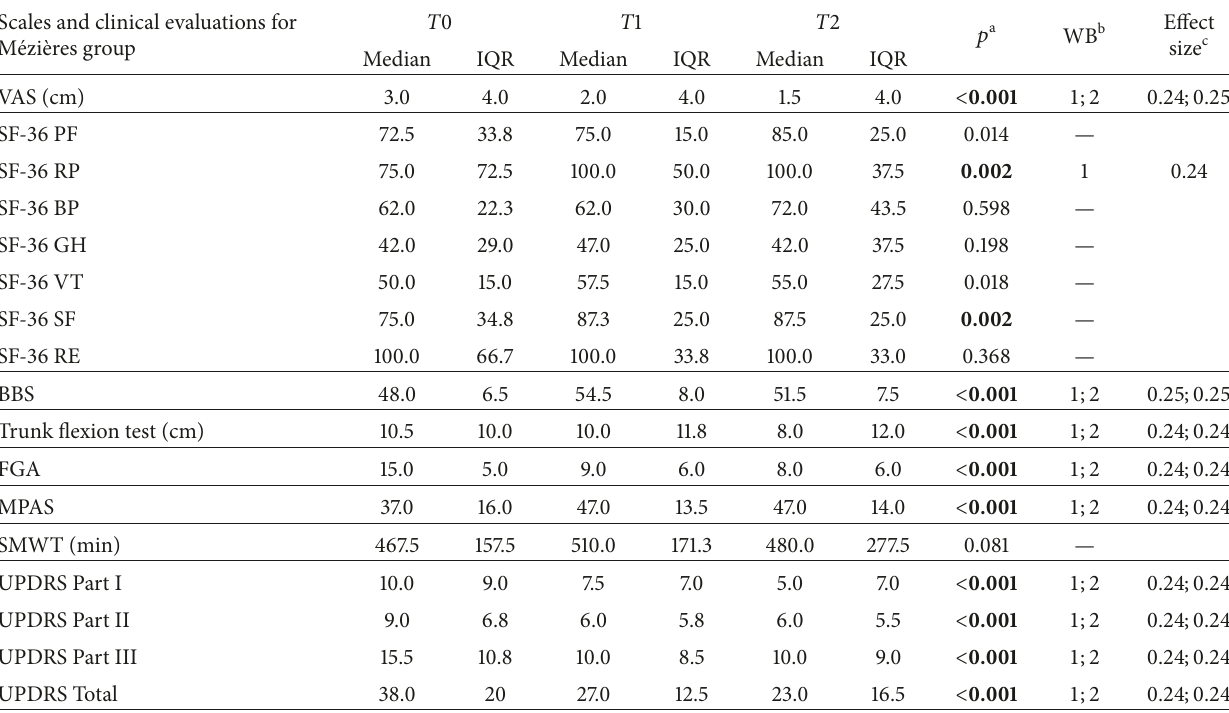
Table 4: Scales and clinical evaluation: comparison for M´ezi`eres group at 3 evaluation times. Scales and clinical evaluations